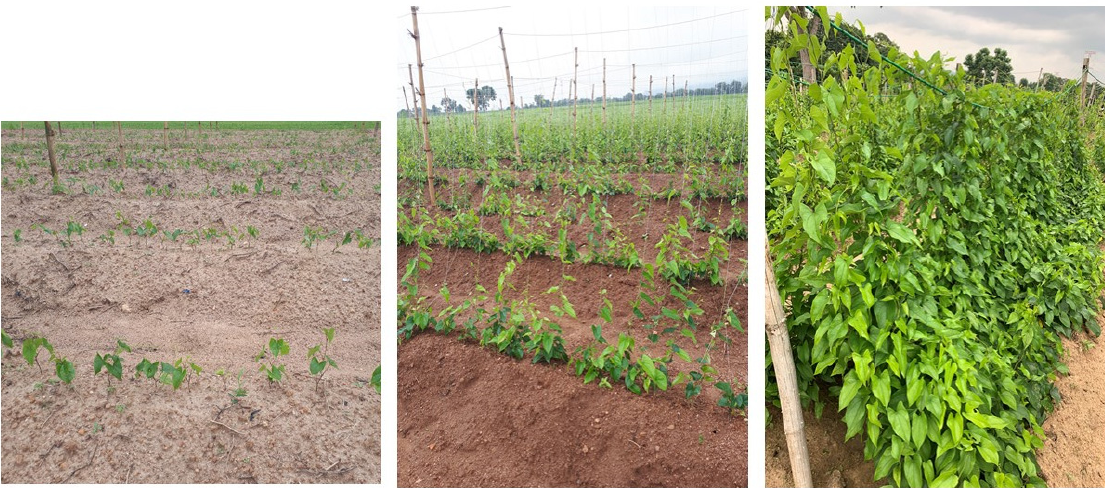
Figure 5. Field planted with 1 g, 3 g, and 5 g minitubers at the International Institute of Tropical Agriculture, Abuja, Nigeria. Plants at three weeks after planting (WAP) ( left ), 5 WAP ( middle ), and 16 WAP ( right ).